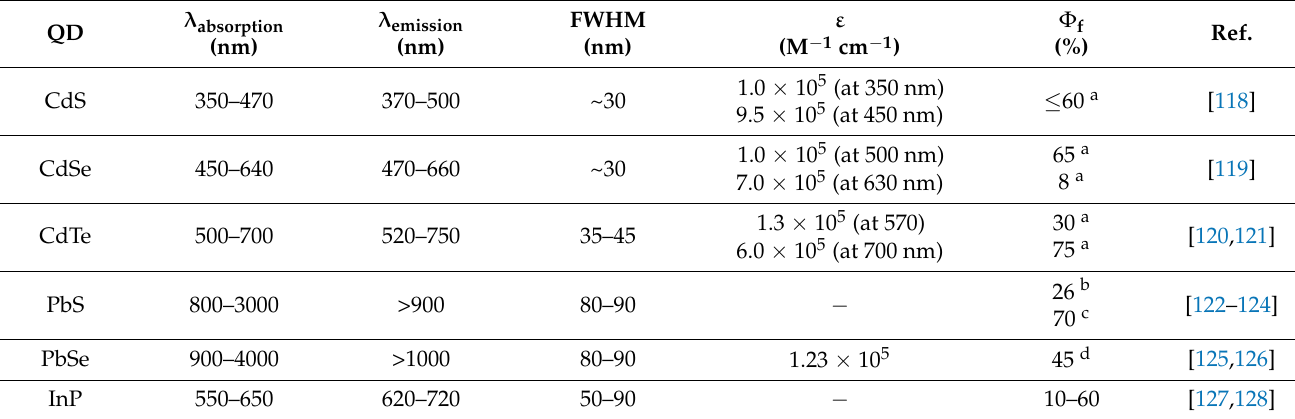
Table 5. Main spectroscopic characteristics of luminescent semiconducting nanocrystals for optical fluorescence imaging. ε is the molar extinction coefficient associated with the main absorption, FWHM the width at half height of the emission band and Φ f the quantum yield.